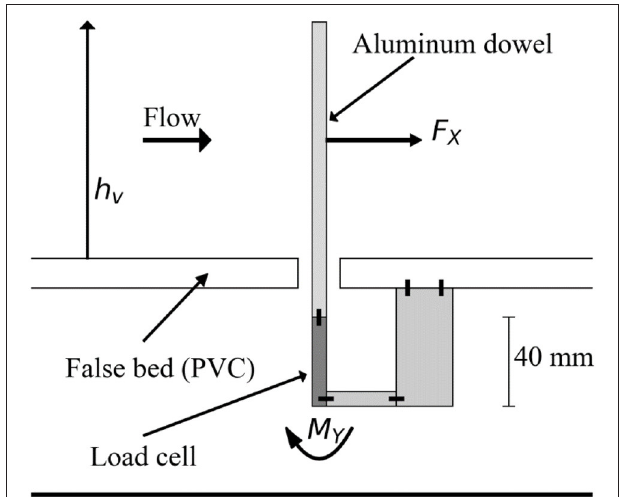
FIGURE 3 | Schematic view of the load cell, which was attached to a single aluminum dowel and placed under the false bed. The drag force ( F x ) due to the flow acting on the dowel translates into a moment ( M y ) around the base of the load